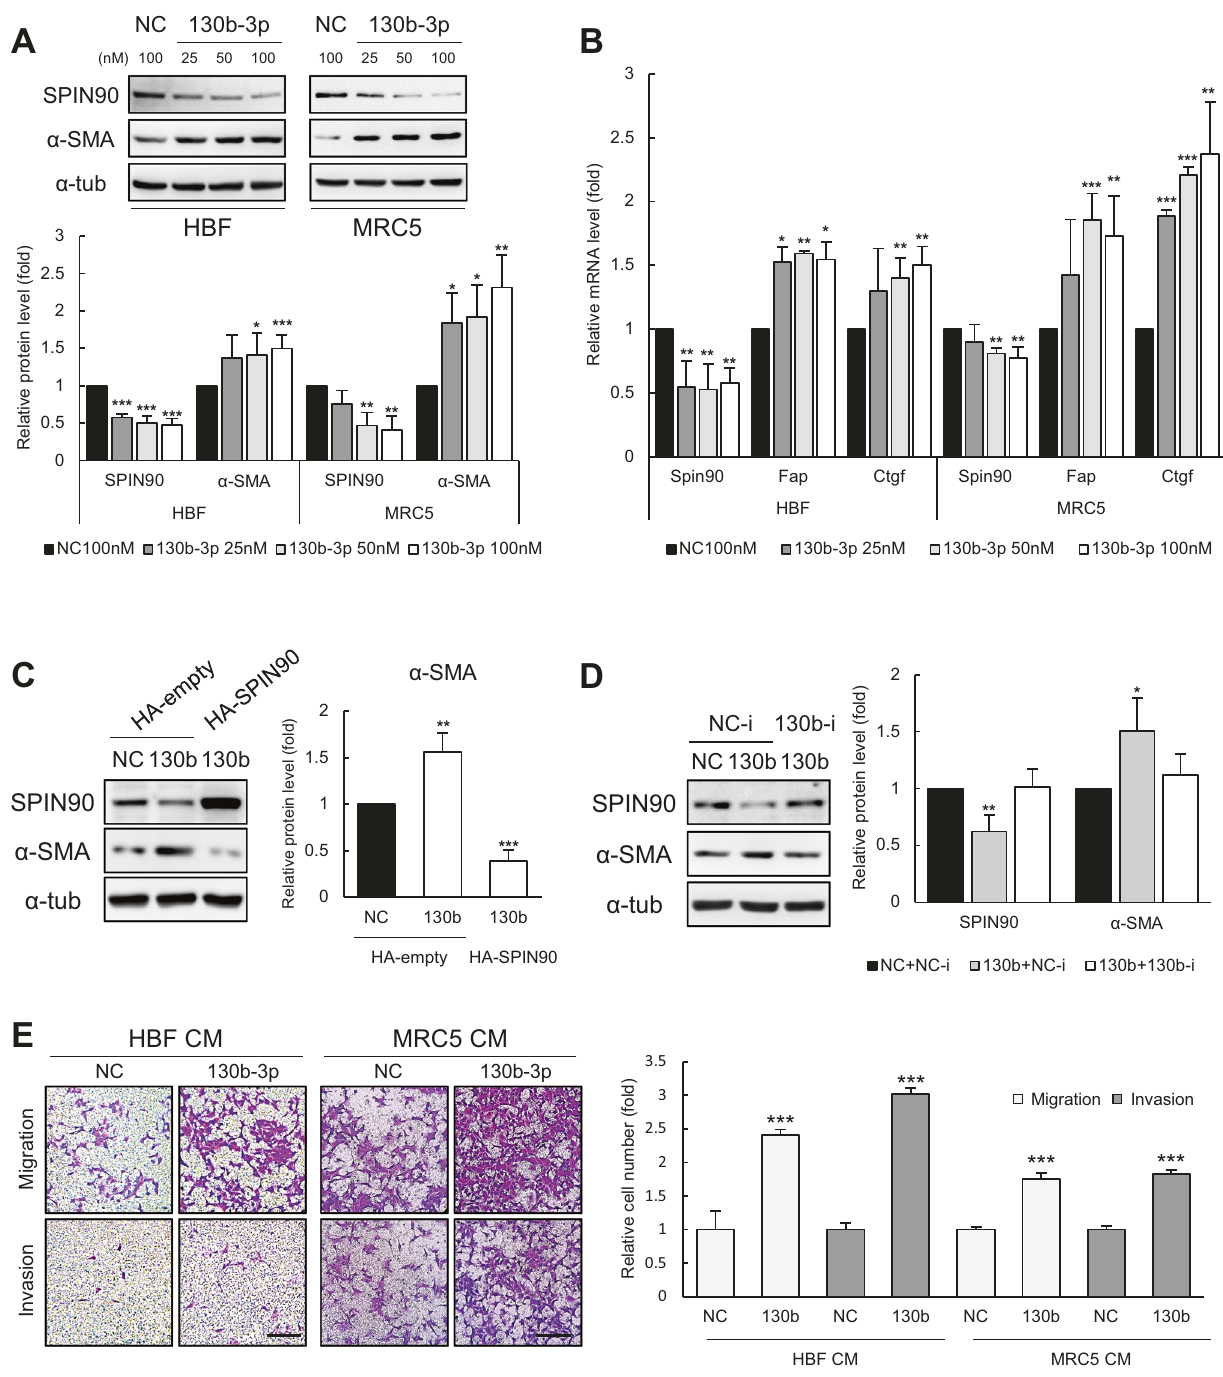
Fig. 3 miR-130b-3p activates fi broblasts to exhibit CAF properties. A Fibroblast activation ability of miR-130b-3p, as assessed by Western blot analysis. miR-130b-3p was transfected to HBFs and MRC5 cells at 25, 50, and 100 nM for 48 h, and histograms were normalized to the expression in the normal control (NC; black bar) of each group ( n = 3). B Relative mRNA expression of Spin90 and myo fi broblast markers, as examined by RT-qPCR ( n = 3). C Recovery of SPIN90 expression in miR-130b-3p mimic transfected HBFs ( n = 3). miRNAs were applied for 24 h, cells were transfected with HA or HA-SPIN90 DNA vector for 24 h, and lysates were collected. D Inhibition of the effect of miR-130b-3p on fi broblasts by transient expression of QIAGEN LNA miR-130b-3p power inhibitor. The oligonucleotides were co-transfected to HBFs with miRNA mimics for 48 h ( n = 3). E Migration and invasion assay of MCF7 cells. CM from miRNA mimic-treated fi broblasts was added to the lower chamber. MCF7 cells were seeded in matrigel-coated or -uncoated upper chambers. Scale bar, 100 μ m. All data are presented as mean ± standard deviation. * p ≤ 0.05; ** p ≤ 0.01; *** p ≤ 0.001 (Student ’ s t -test). NC negative control of miRNA mimic; 130b and 130b-3p, miR- 130b-3p mimic; NC-i, inhibitor of negative control; 130b-i, inhibitor of